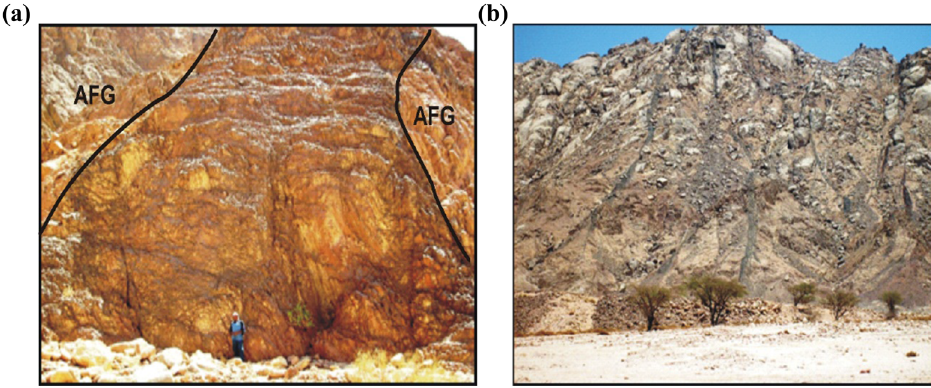
Figure 2: Field photographs showing ( a ) alkaline granophyre dike cutting alkali feldspar granite ( AFG ) at Wadi Abura; striking at ENE; and ( b ) dyke swarms of basalt cutting syenogranite at Wadi Geba; striking at N